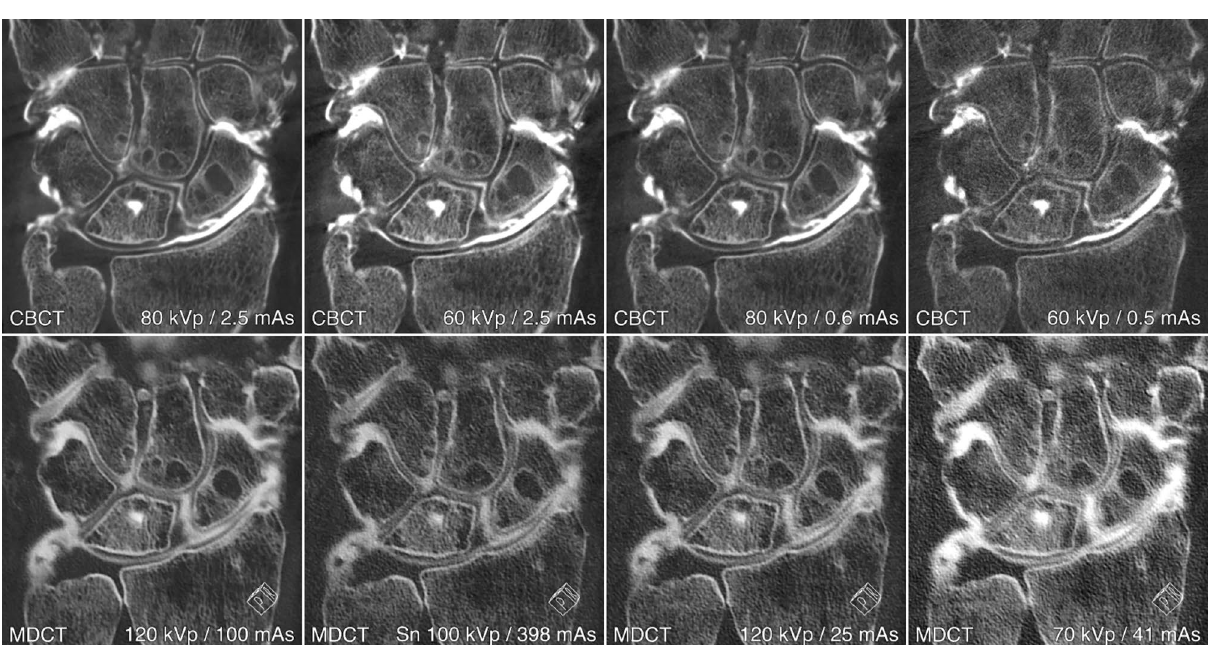
Figure 4. Coronal view of various scan protocols (in descending order of radiation dose) depicts a scapholunate ligament tear. Visualization of the tear’s location in the scaphoid portion of the ligament is superior in cone- beam CT scan (CBCT; upper row). Despite being acquired 30 minutes later, the blurriness of multidetector CT images (MDCT; lower row) partially offsets the advantage of increased articular distension for cartilage assessment, for example in the radiocarpal